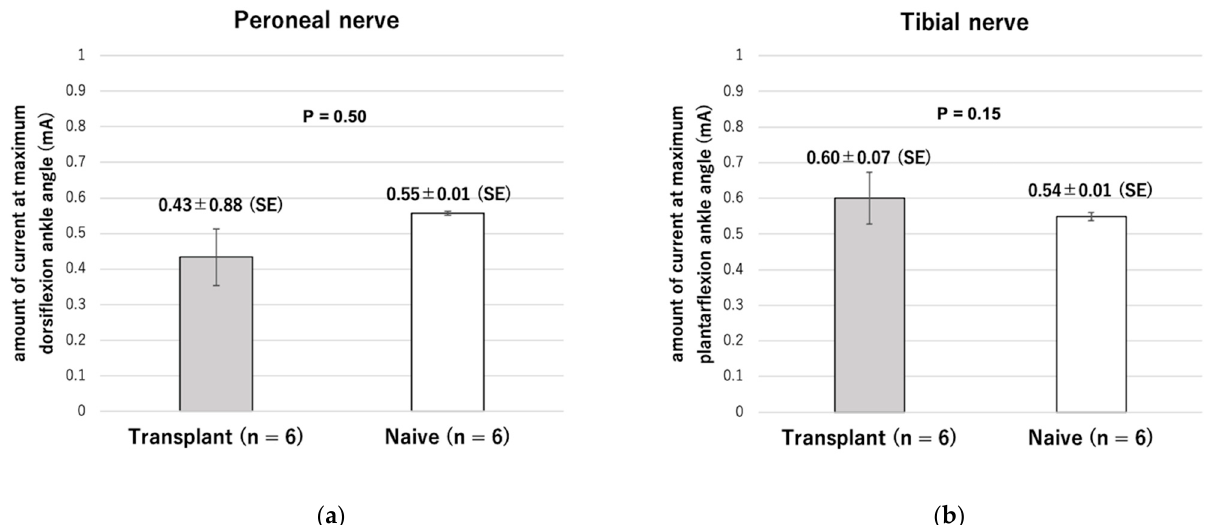
Figure 7. Changes in maximum ankle angle during electrical stimulation. ( a ) Maximum dorsiflexion while stimulating the peroneal nerve. ( b ) Maximum plantar flexion while stimulating the tibial nerve. * P<0.05